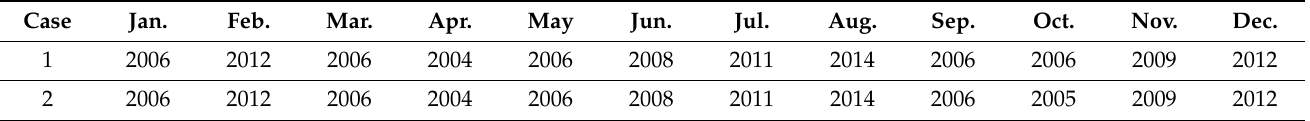
Table 2. TMMs determined using two sets of weighting factors for the Taichung weather station: (1)